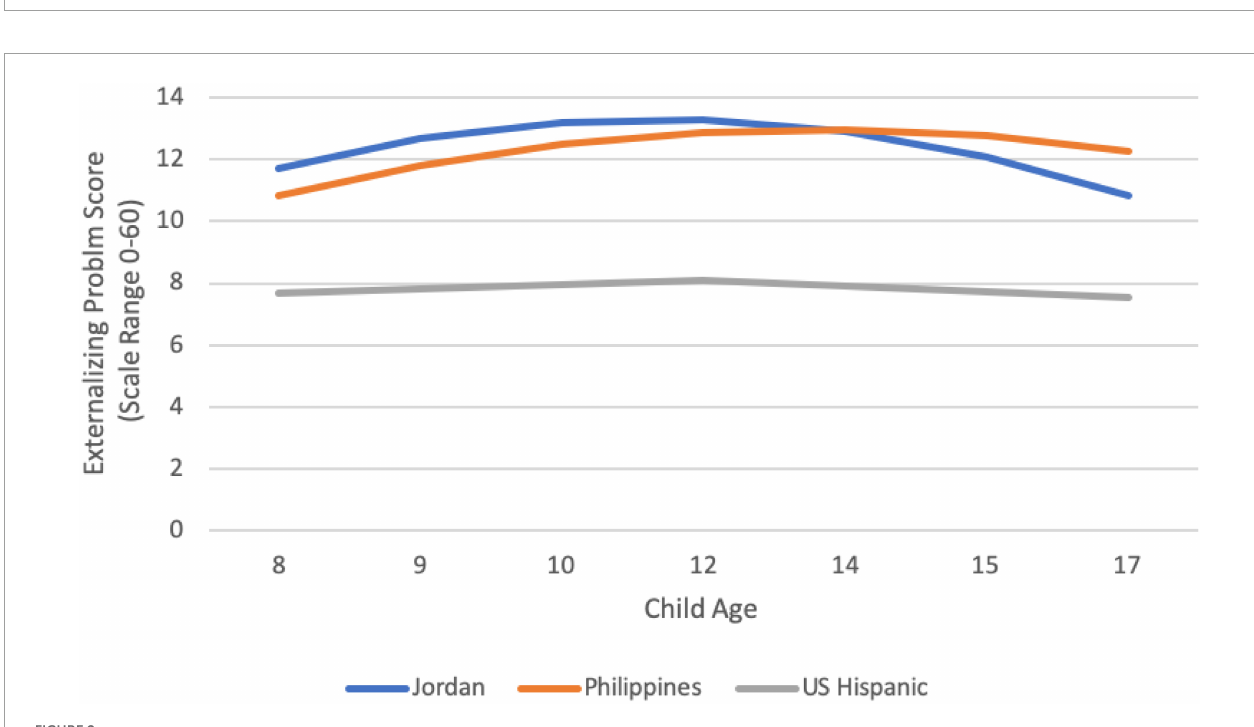
FIGURE2 Cultural group-specific observed externalizing